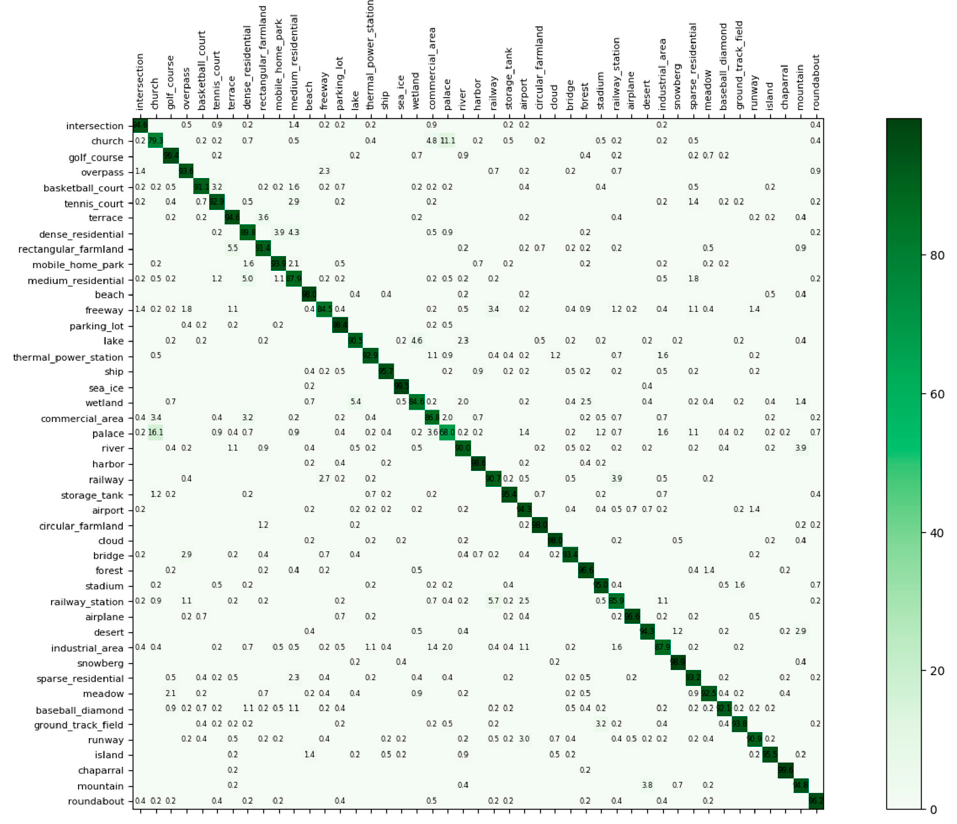
Figure 17. Confusion matrix of the proposed method on the NWPU-RESISC45 dataset by fixing the training ratio as 20%.